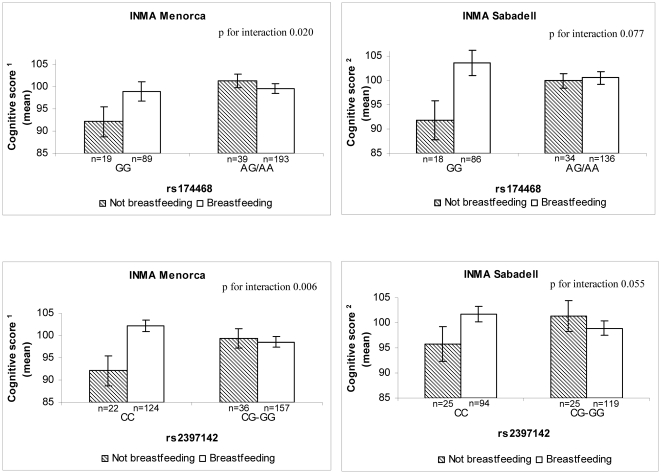
Child cognition scores by child' genetic SNPs in the FADS gene cluster (rs174468) and ELOVL5 gene (rs2397142), by breastfeeding and cohort.Bars represent standard error. 1Adjusted for sex, school trimester at testing, maternal social class, maternal education, maternal smoking and alcohol consumption in pregnancy, indoor nitrogen dioxide (NO2) levels. 2Adjusted for sex, child age (in days), psychologist, quality of neuropsychological test, maternal education, and use of gas stove at home.